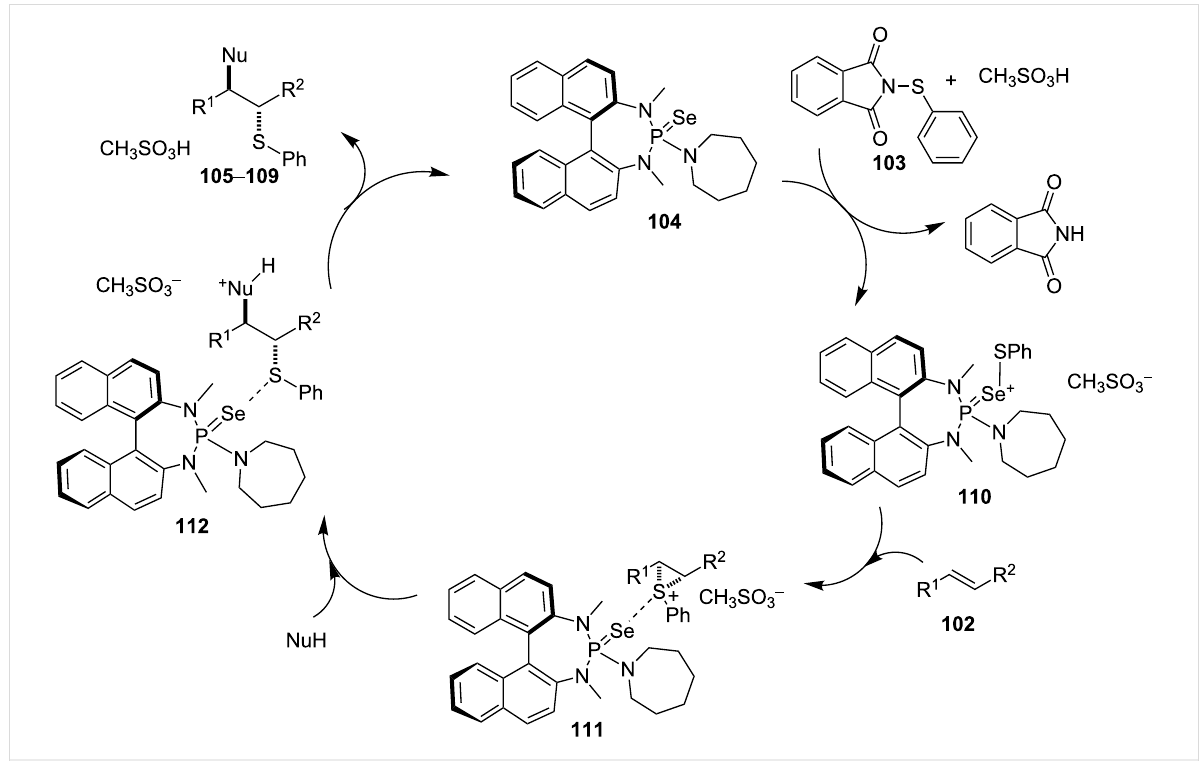
Scheme 40: Proposed catalytic cycle for asymmetric sulfenofunctionalization.